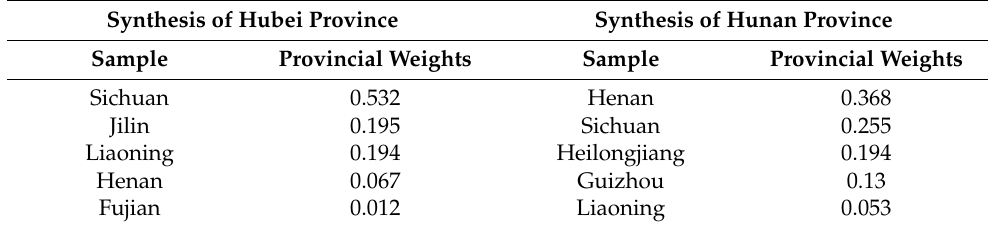
Table 4. Nonzero weights of samples for synthetic GDP per